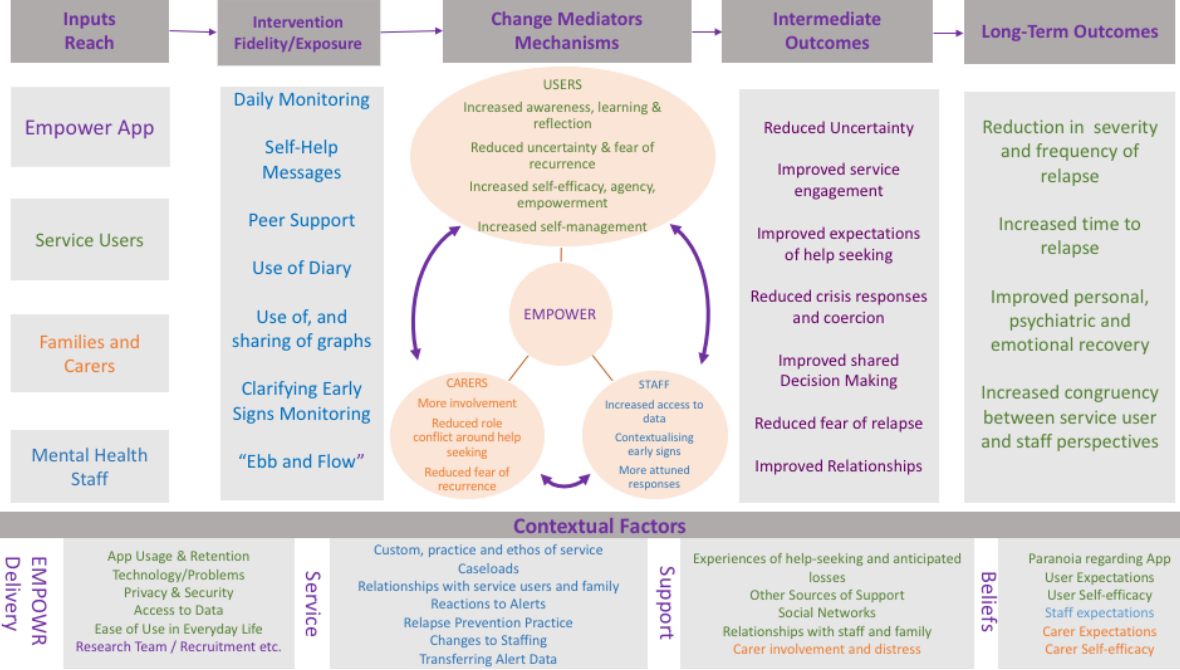
Figure 1. The logic model-based process evaluation framework for the Early Signs Monitoring to Prevent Relapse in Psychosis and Promote Well-Being, Engagement, and Recovery (EMPOWER)